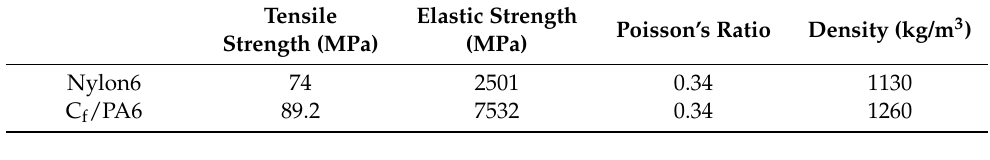
Table 1. Mechanical properties of molded 2.3-mm-thick C f /Nylon 6 composite coupons.